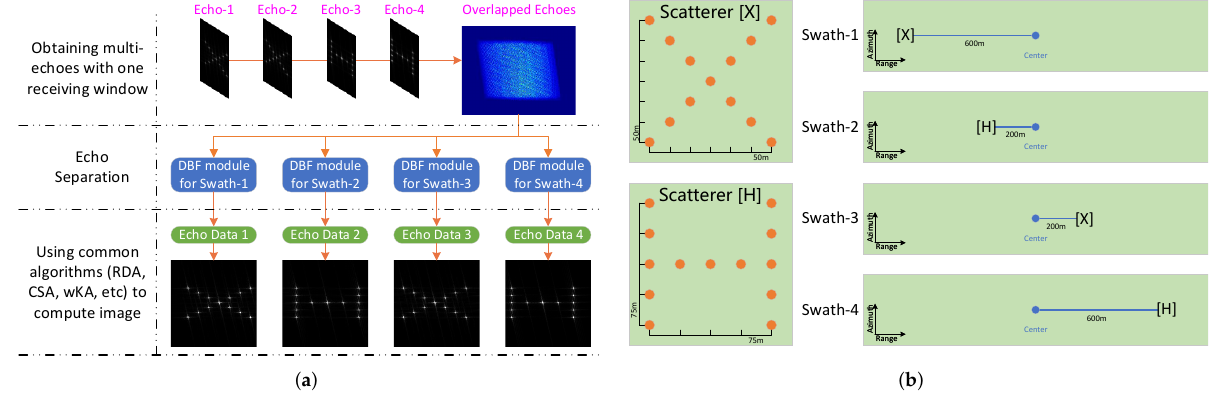
Figure 15. ( a ) The simulation flow. ( b ) The geometric relationship among the point